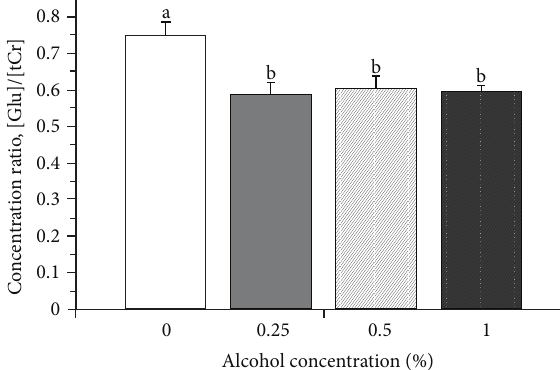
Figure 3: Acute, 1h long, alcohol exposure increases glutamate to total creatine ratio ([Glu]/[tCr]) in zebrafish brain: mean ± SEM (𝑛 = 10) . Bars not sharing a letter designation are significantly different from each other (𝑃 < 0.05) . Observe the apparent decrease in [Glu]/[tCr] at all acute doses and note that the experimental groups significantly differ from the